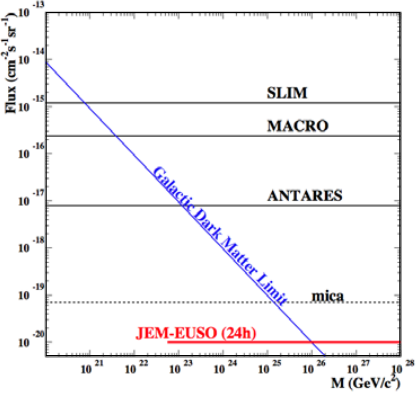
Figure 1. The 90% confidence level upper limit on the flux of nuclearites of experiments with different techniques [7–9, 12]. The “old” mica limits [12] are dependent from several additional assumptions, respect to the other experiments. The lower line shows the possible limit in 24h of the JEM-EUSO cosmic ray experiment planned for the international space station [5]. Note that most of the proposed quark nuggets have energy losses bigger than the neutral nuclearites. Therefore limits applies to many other